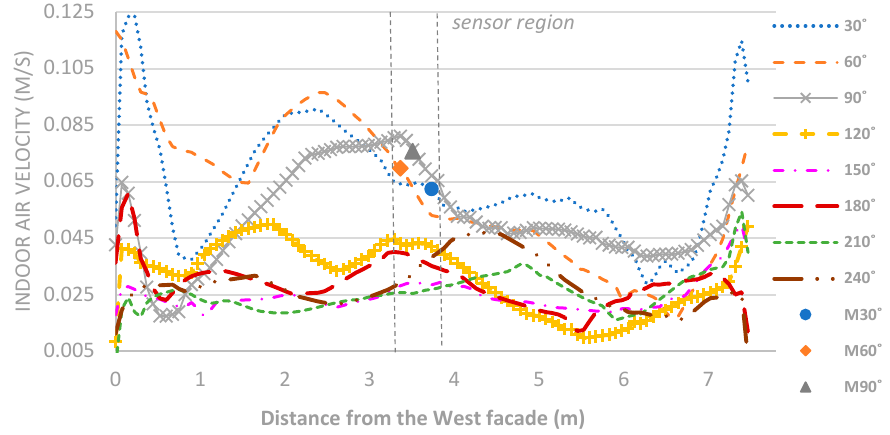
Figure 10. Predicted indoor air velocities (m/s) at 100 points along a measuring line (longitudinal) with measured values at θ = 30°, θ = 60°, and θ = 90° wind directions.